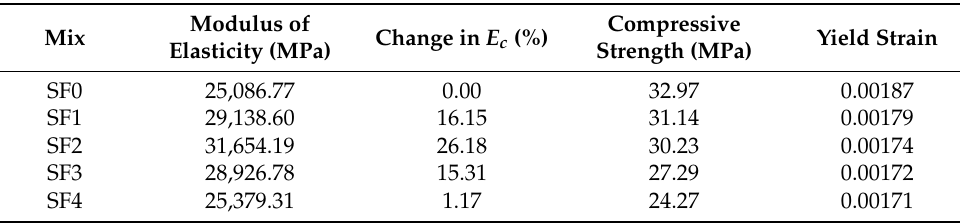
Table 8. Modulus of elasticity